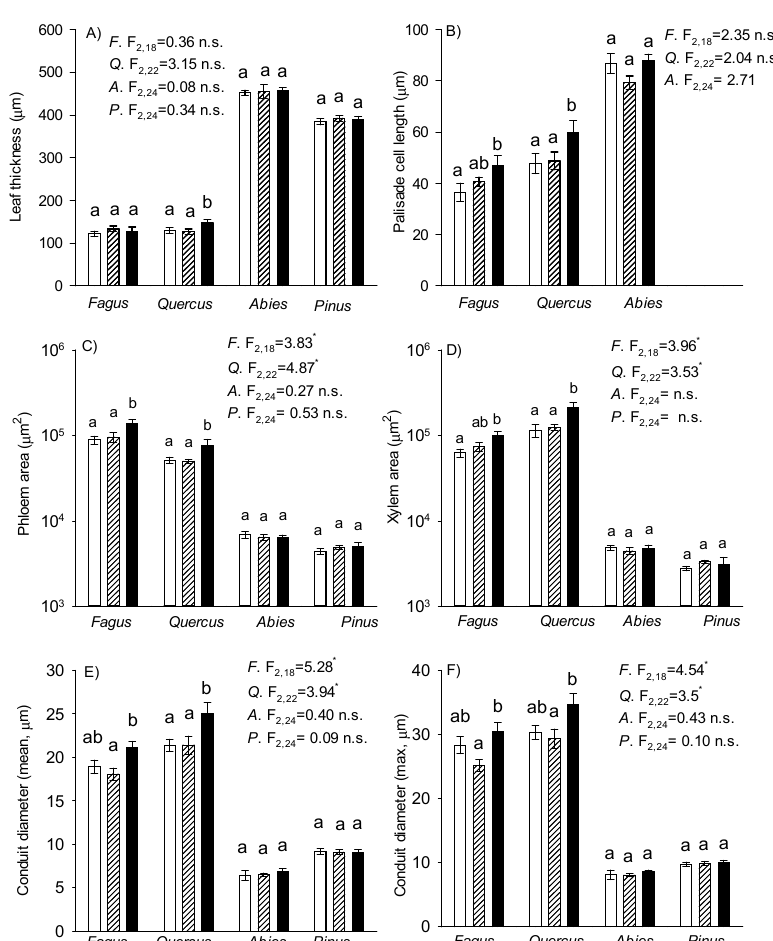
Figure 5. Anatomical parameters in leaves of Fagus sylvatica and Quercus petraea , and needles of Abies alba and Pinus sylvestris leaves in seedlings grown under different levels of irrigation (100%, 50% and 25% of the recommended levels). Bars represent the mean (±S.E.) ( n = 8, n —number of seedlings per species and irrigation treatment). Anatomical features such as leaf thickness ( A ), palisade cell length ( B ), transverse midvein phloem ( C ) and xylem area ( D ), and within-leaf mean ( E ) and maximal ( F ) conduit diameter are shown. One-way analysis of variance F -values for treatment effect and the associated p values are shown separately for each species. F .— Fagus , Q .— Quercus , A .— Abies , P .— Pinus . Means marked by the same letters (a, b) within species were not significantly different. P symbols are: *** p < 0.001, ** p < 0.01, * p < 0.05, n.s.—not significant.